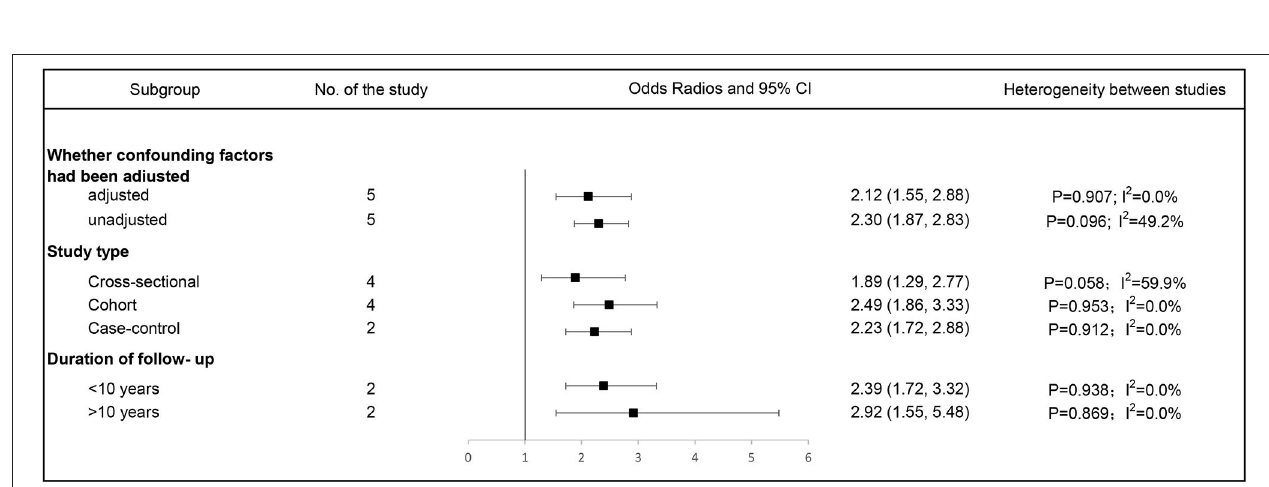
FIGURE 3 | Subgroup analysis of the association between diabetic retinopathy and cognitive impairment. Forest plot and pooled estimates of the association between diabetic retinopathy and cognitive impairment, stratified by whether confounding factors had been adjusted, study type, and duration of follow-up. Each subgroup corresponds to a horizontal line and a square. The square represents the pooled estimate, and the length of the horizontal line represents the 95% confidence interval. The vertical at 1 indicates that diabetic retinopathy is not associated with cognitive impairment.